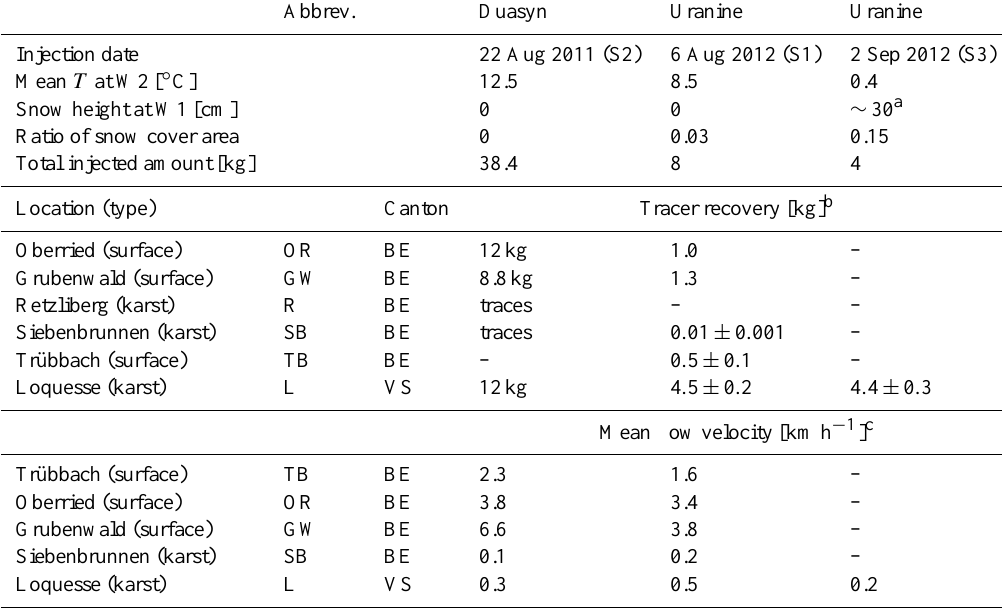
Table 4. Overview of the tracer recovery in karst and surface runoffs after injections at location I2.